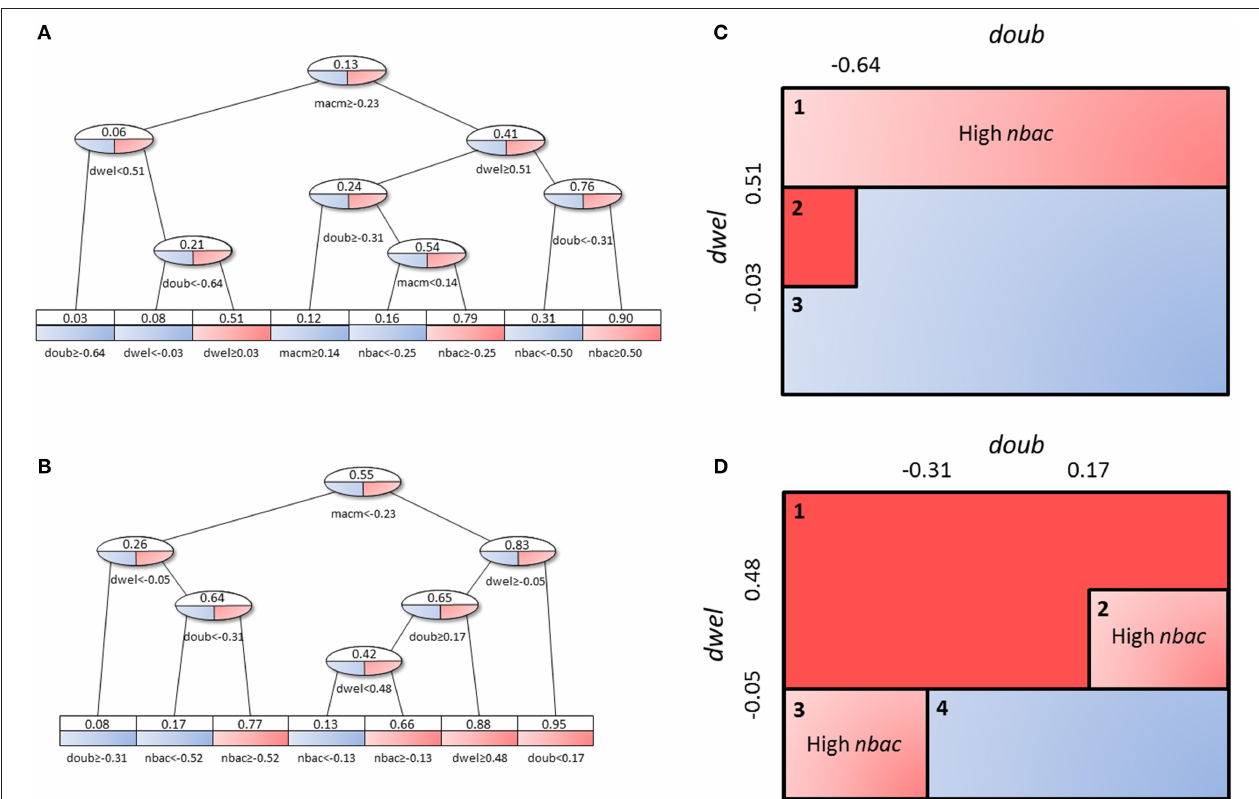
FIGURE 10 | Decision tree analysis on tissue-level parameter values in the combined low load and high load groups. Red represents a set of solutions whose average infectivity is equal to or higher than 0.5, while blue stands for infectivity lower than 0.5. The intermediate steps (ovals) show both colors, as they cannot be classified unanimously at this level. Solutions with high macrophage movement speed (A) are separated from those with low macrophage movement speed (B) . The original tree can be seen in Figure S4. (C,D) represent an alternative depiction of the subpopulations from (A,B), respectively. Three and four different subpopulations respectively were identified depending on the range of values of dwel and doub . Blue boxes indicate low-infectivity subgroups, dark red boxes high infectivity subgroups and light red boxes indicate subpopulations that achieve high infectivity if the criterion inside the box is